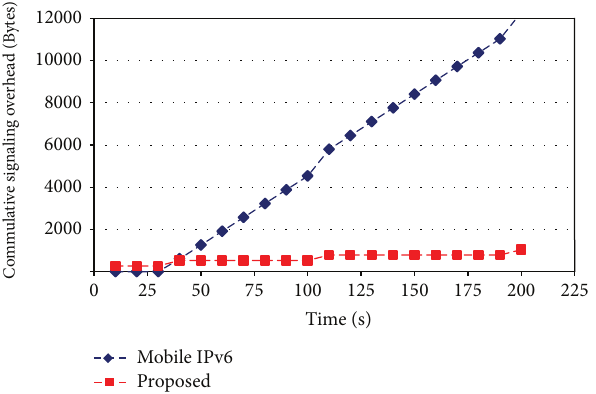
Figure 10: Packet loss comparison as a function of time.